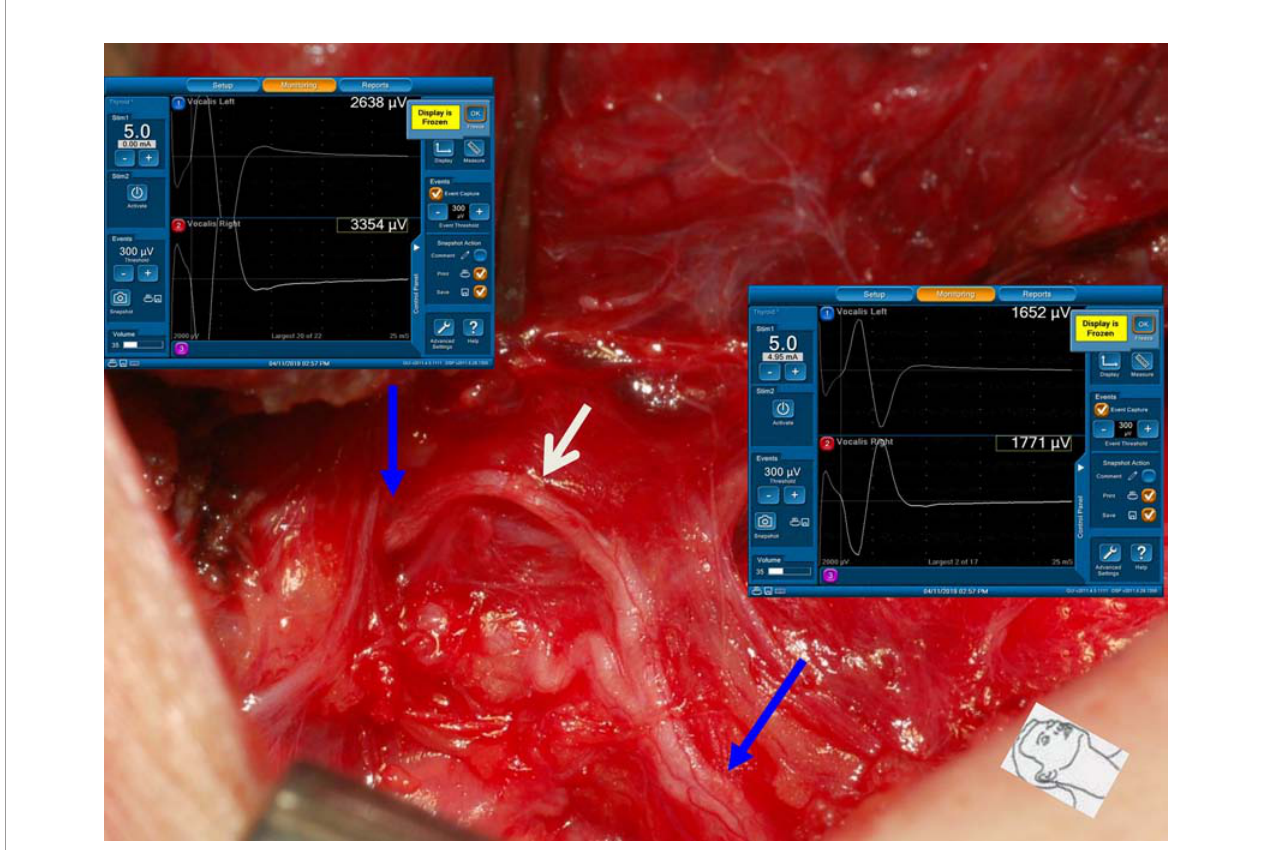
FIGURE 1 | A case of type 1 incomplete LOS. The anterior motor branch of the RLN was stretched upward during medial thyroid traction. After complete RLN dissection and comparing R 2p signal (1771 µV) with R 2d signal (3354 µV), it showed an amplitude reduction of approximately 47%, and a weak point of nerve conduction was mapped (white